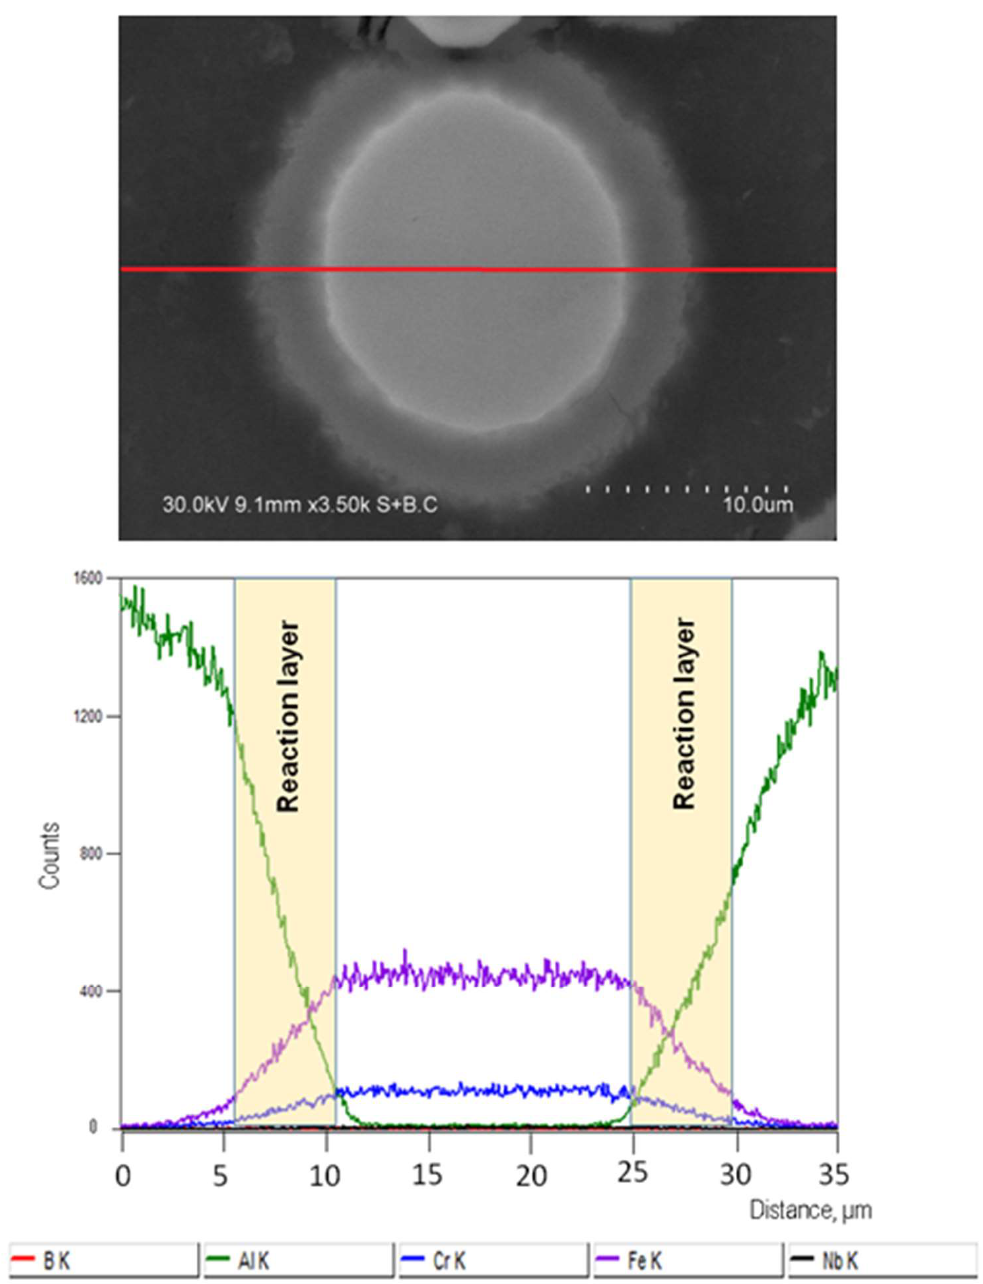
Figure 6. Fe-based alloy particle in an Al matrix, composite sintered at 540 °C, 3 min, and results of the EDS analysis along the red line on the image.